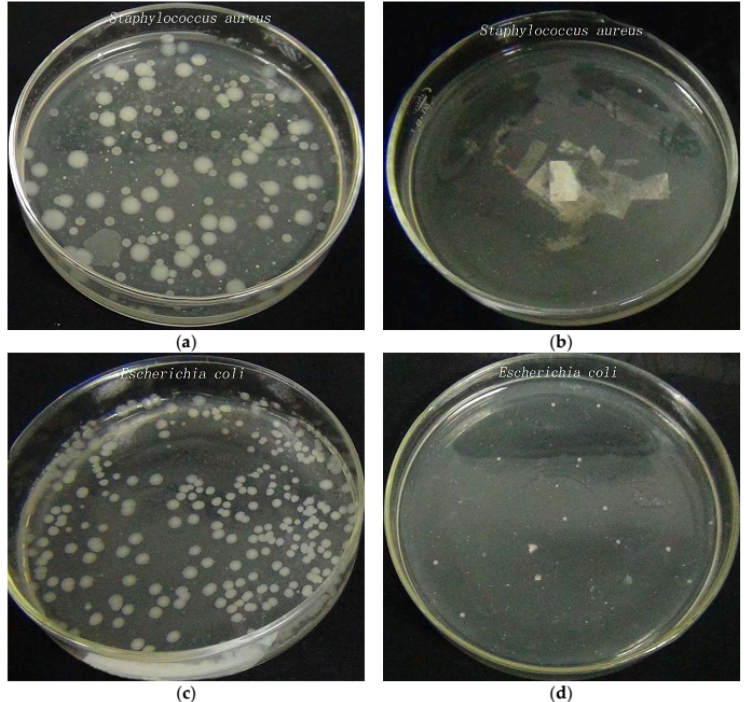
Figure 9. Shake flask antimicrobial test results of ( a ) control sample against S. aureus ; ( b ) ZnO/Ag coated polyester nonwoven (4#) against S. aureus ; and ( c ) control sample against E. coli ; ( d ) ZnO/Ag coated polyester nonwoven (4#) against E. coli